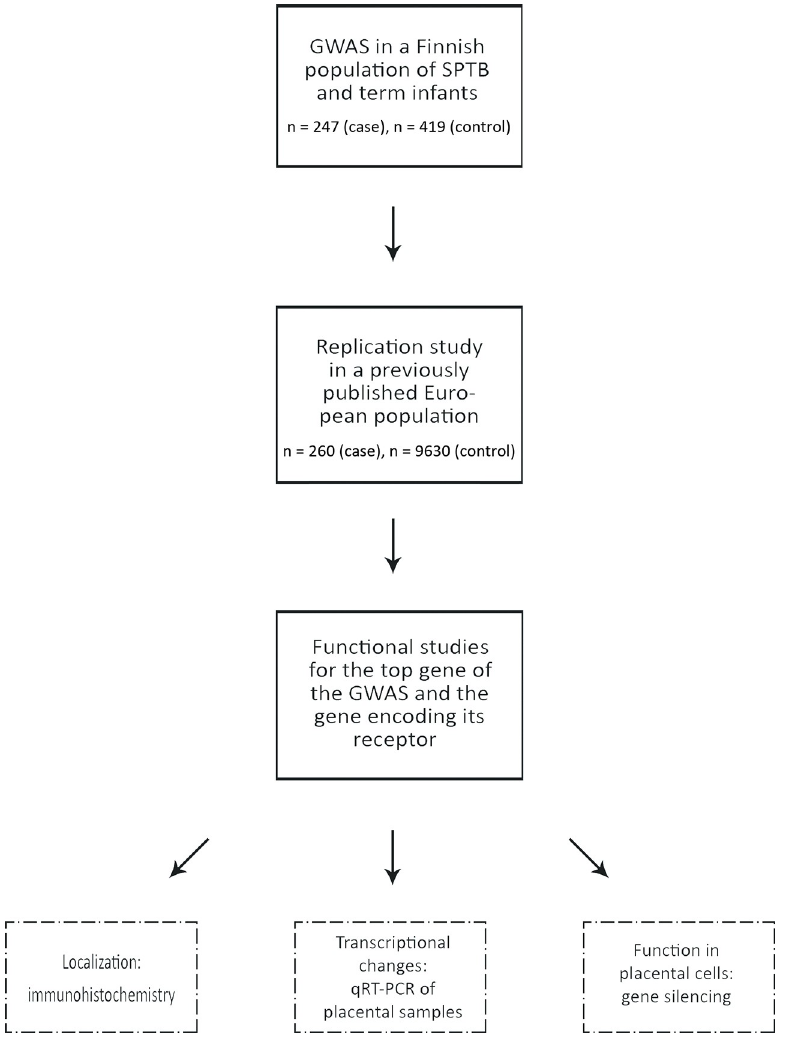
Fig 1. Overview of the study workflow.